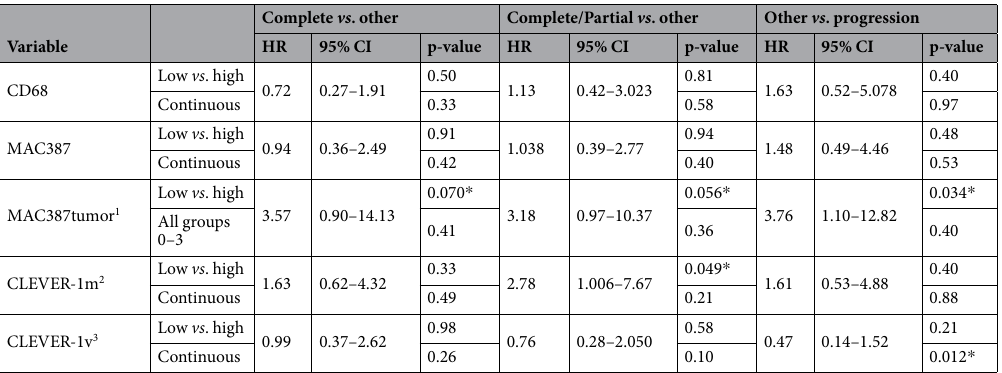
Complete vs . other Complete/Partial vs . other Other vs . progression Variable HR 95% CI p-value HR 95% CI p-value